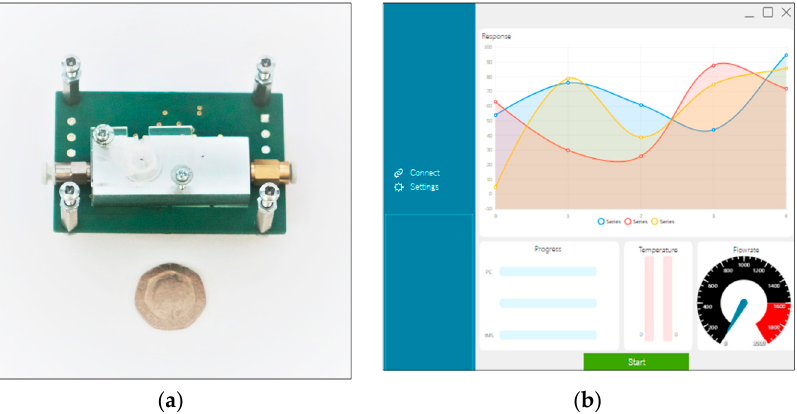
Figure 2. ( a ) Bottom view of the sensor showing the ionization chamber, UV lamp, inlet and outlet; ( b ) The PID control software designed using Visual Studio